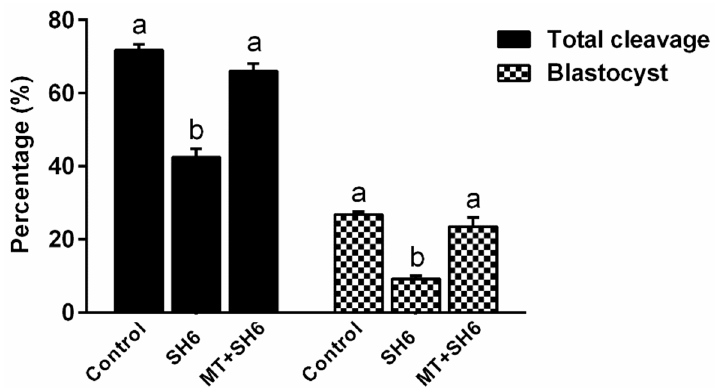
Figure 2. Effect of melatonin treatment during IVM on the development of SH6-treated oocytes. Oocytes were in vitro matured during exposure to 50 µM of SH6 in the presence or absence of melatonin (10 − 8 M) for 22–24 h. Data are expressed as mean ±SEM. Values with different superscripts indicate statistical significance ( p < 0.05).